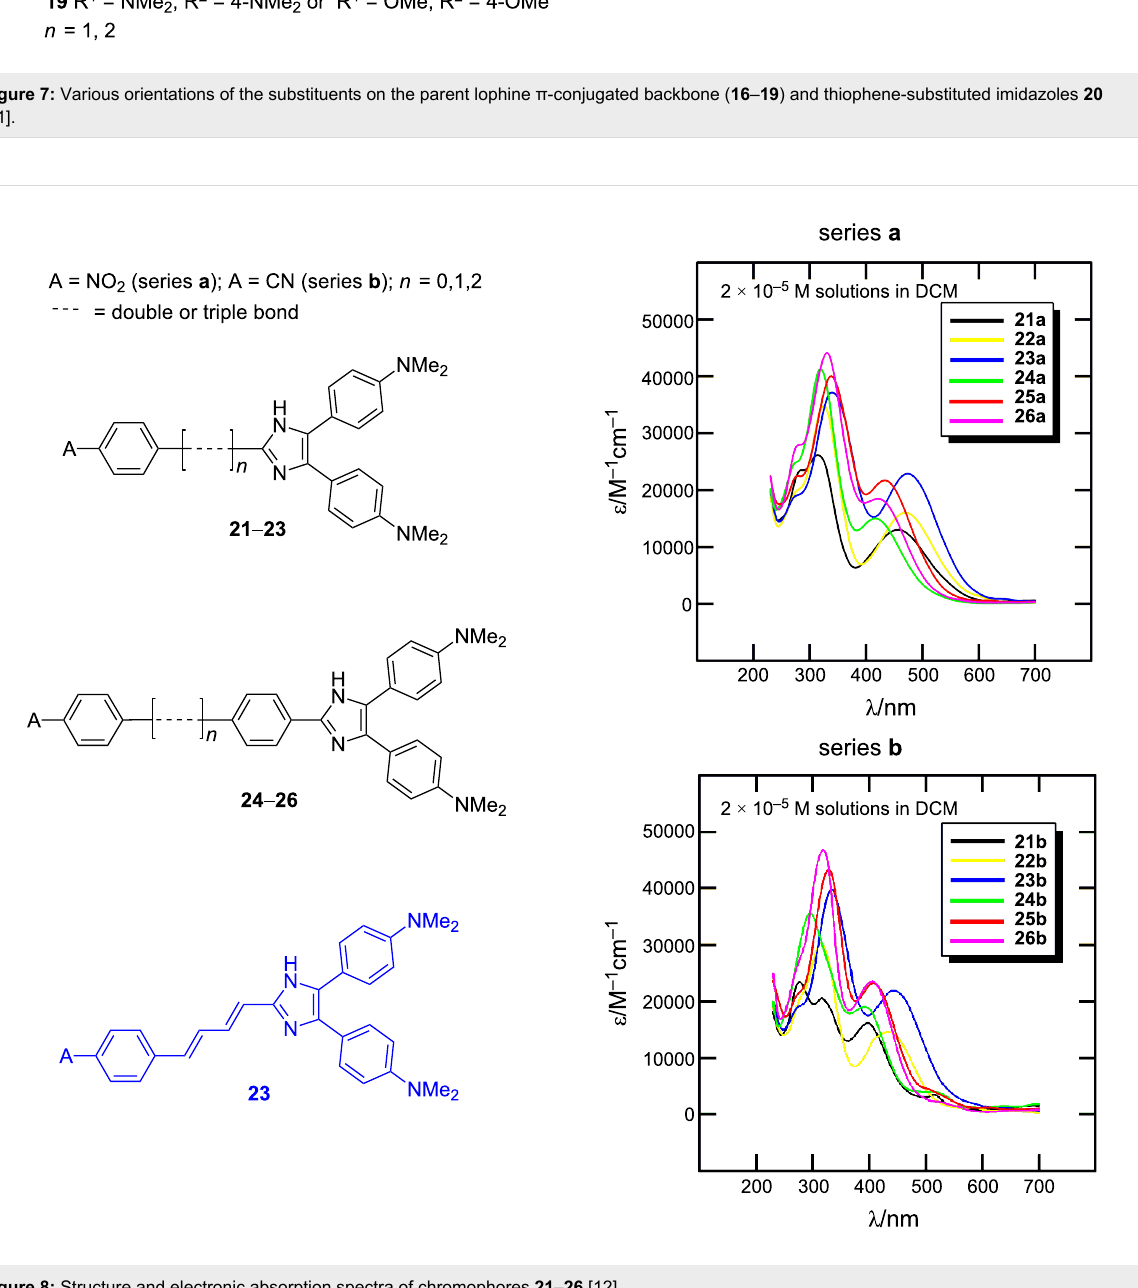
Figure 8: Structure and electronic absorption spectra of chromophores 21 – 26